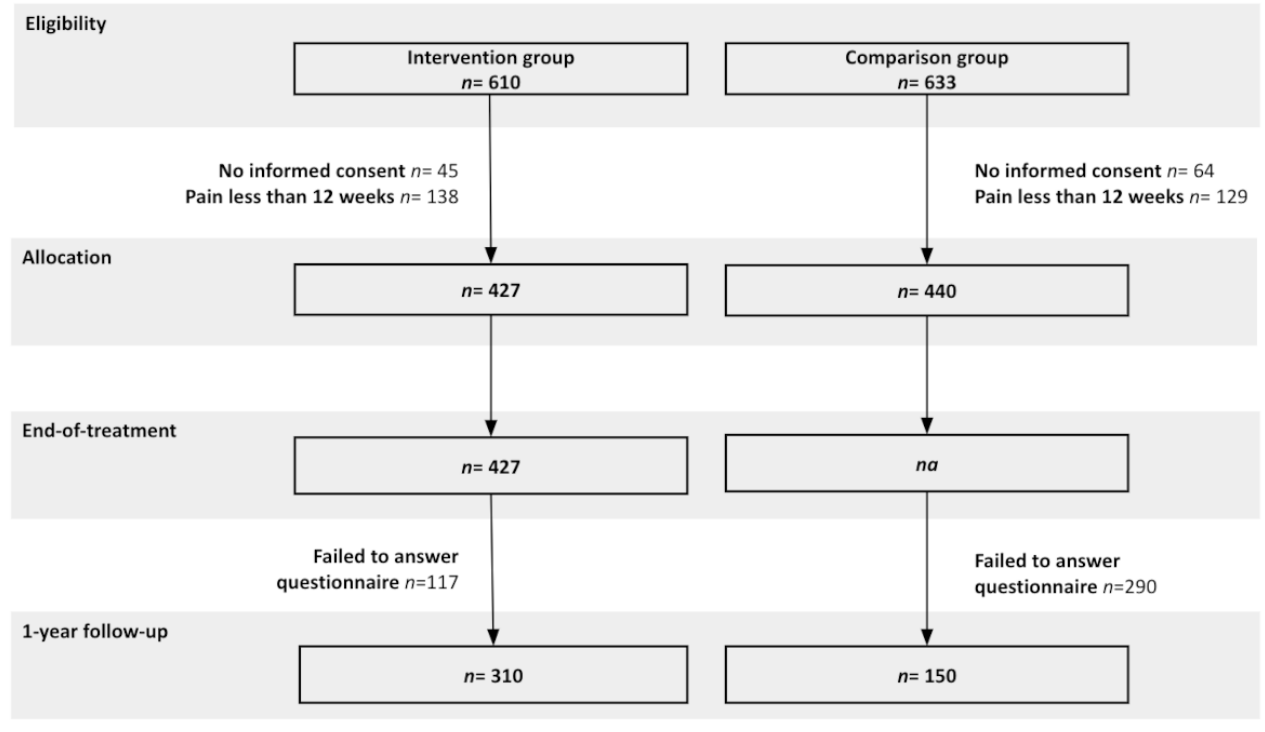
Figure 1. Study flow chart.